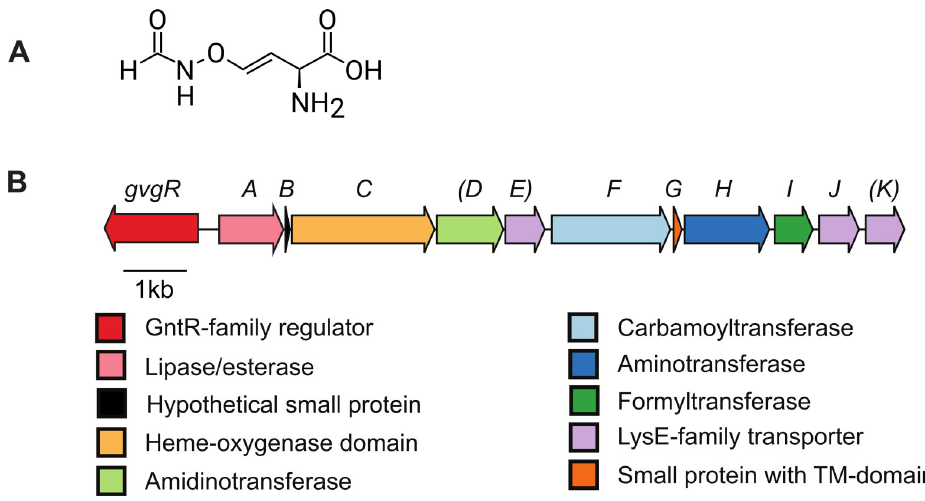
Fig 1. Structure of the 4-formylaminooxyvinylglycine compound and the gene cluster necessary for its production. (a) Structure of 4-formylaminooxyvinylglycine (FVG). (b) Organization of the gvg gene cluster from Pseudomonas fluorescens WH6. Arrows representing genes are colored based on the function of the encoded proteins. Gene notations in parentheses are not required for FVG